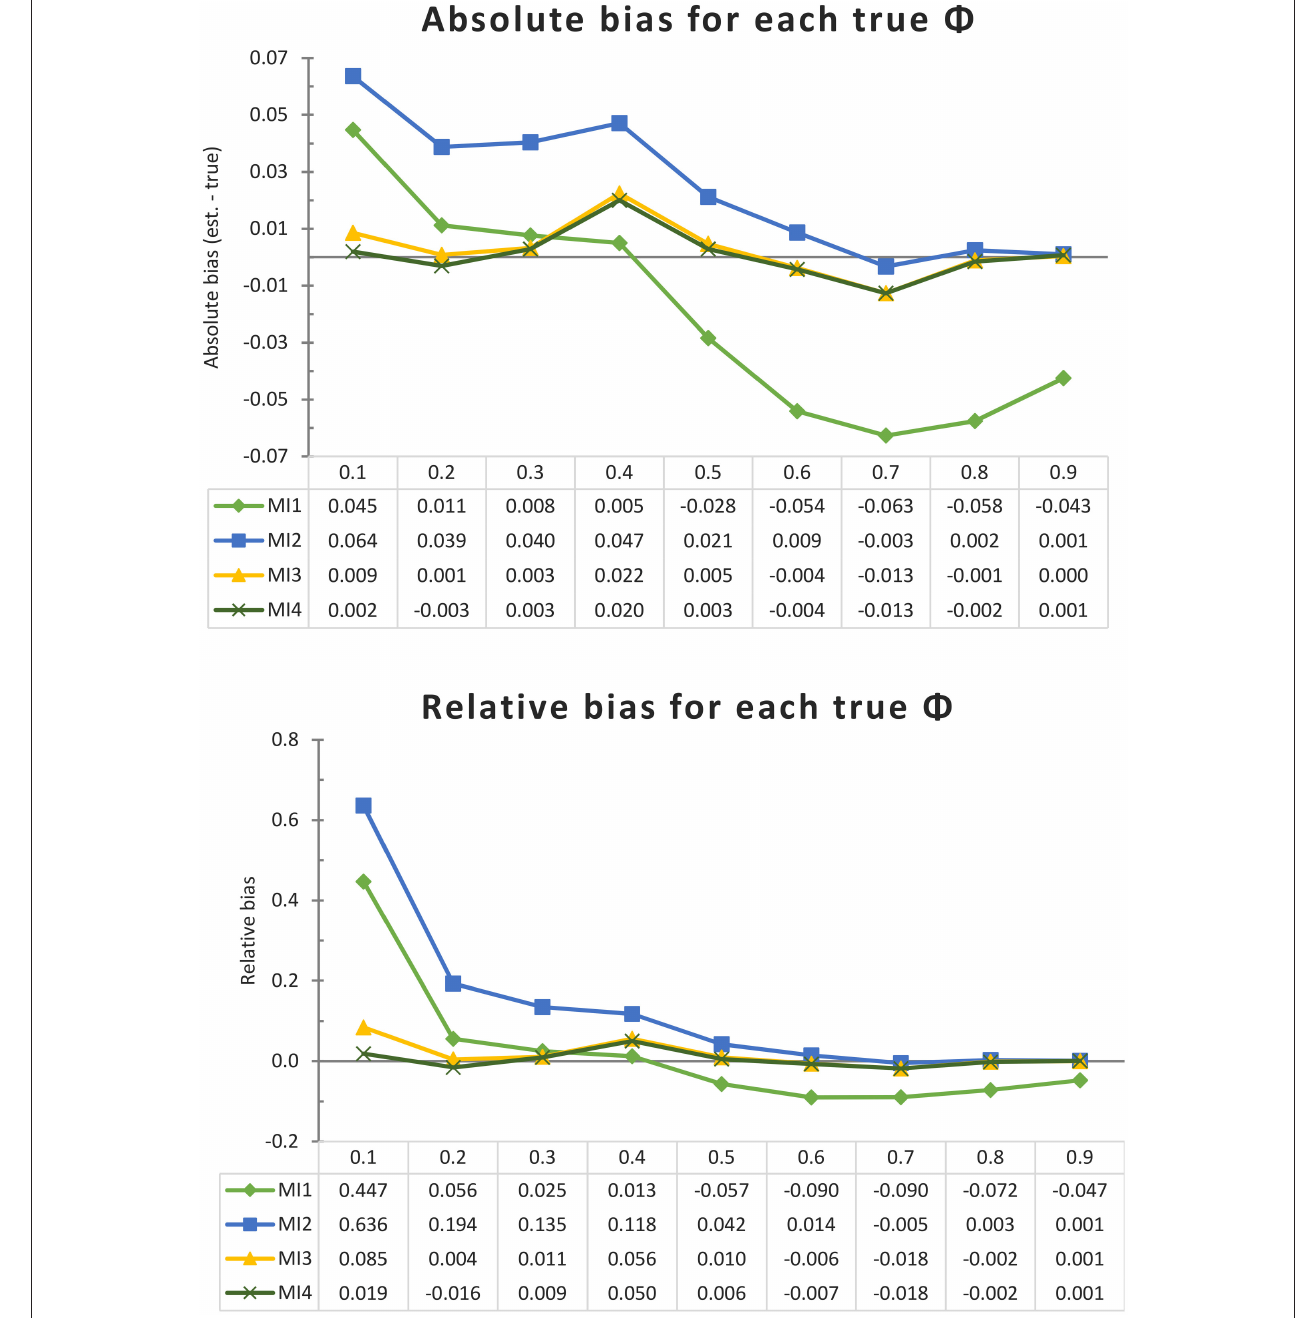
FIGURE 3 | Absolute and relative bias for each model implementation and each true φ in the univariate simulation with one very long time series (of 1,000 days) and no minimum interval length. Each line represents a model implementation, and on the X-axis we have the nine different true values of φ .